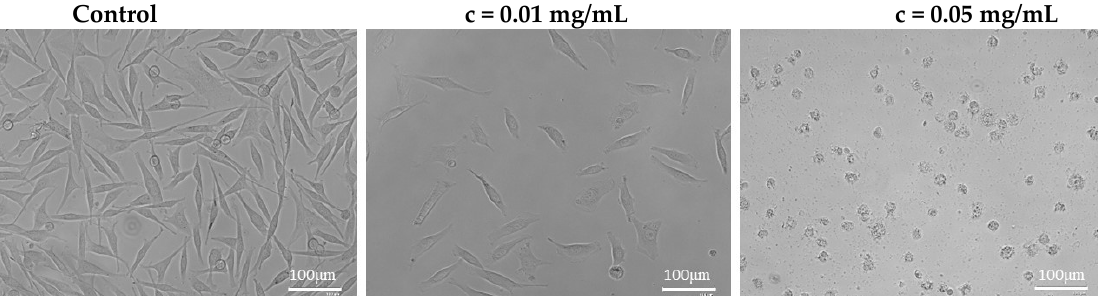
Figure 4. Morphology of melanoma cells WM-266-4 after applying the mixG extract solution concentrations 0.01 mg/mL and 0.05 mg/mL compared to control.